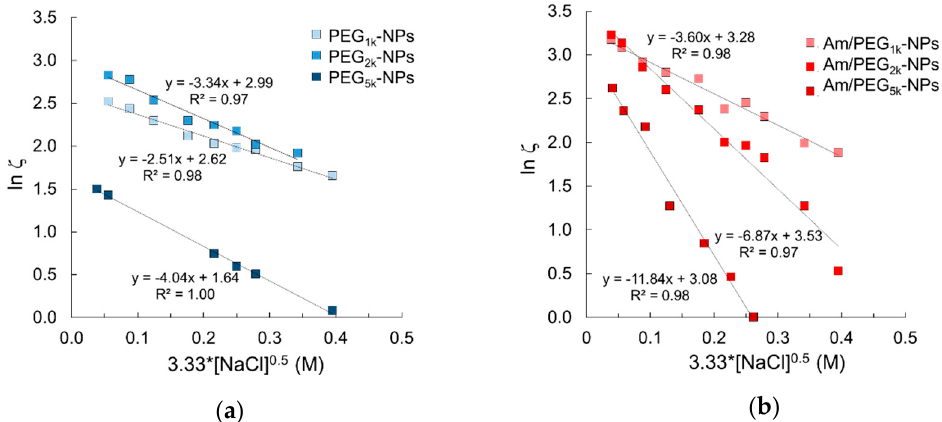
Figure 3. Fixed aqueous layer thickness (FALT) measurements for ( a ) PEG-NPs and ( b ) Am / PEG-NPs.